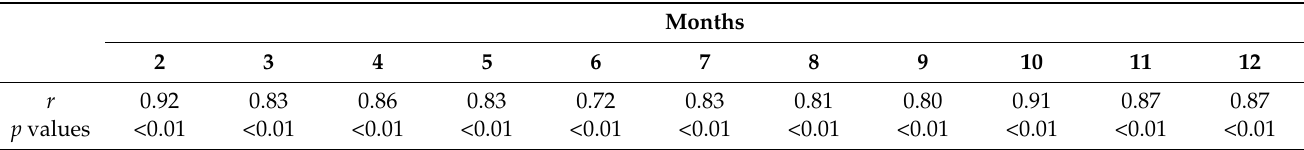
Table 3. Correlation between the PCA-MRM (L31, mean.lag1.2) forecasted and the observed TEC values for different